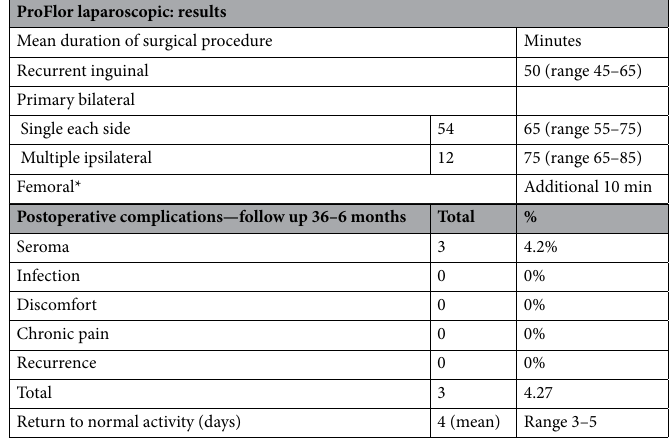
Table 3. Results of laparoscopic ProFlor technique in examined patient cohort. *All three femoral defects were concomitant hernias. One was detected during recurrent inguinal hernia repair and the remaining two during bilateral repair procedures.